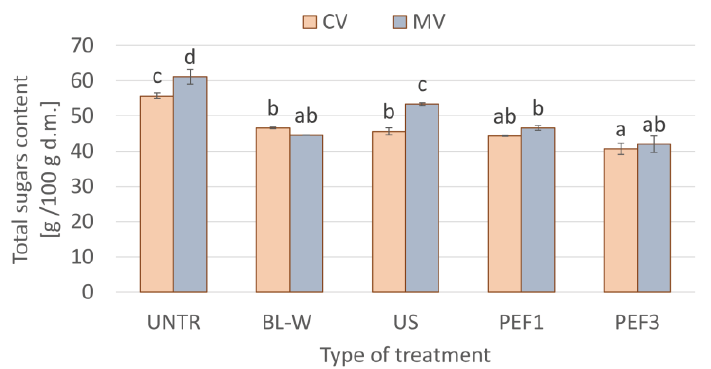
Figure 8. Comparison of total sugars content for convective (CV) and microwave – convective (MV) dried red bell pepper subjected to thermal or non-thermal treatment prior to drying. Column presents a mean (from 3 repetitions), and errors bars show standard deviation. The different letters above columns show different homogeneous groups (Tukey’s HSD, α = 0.05).